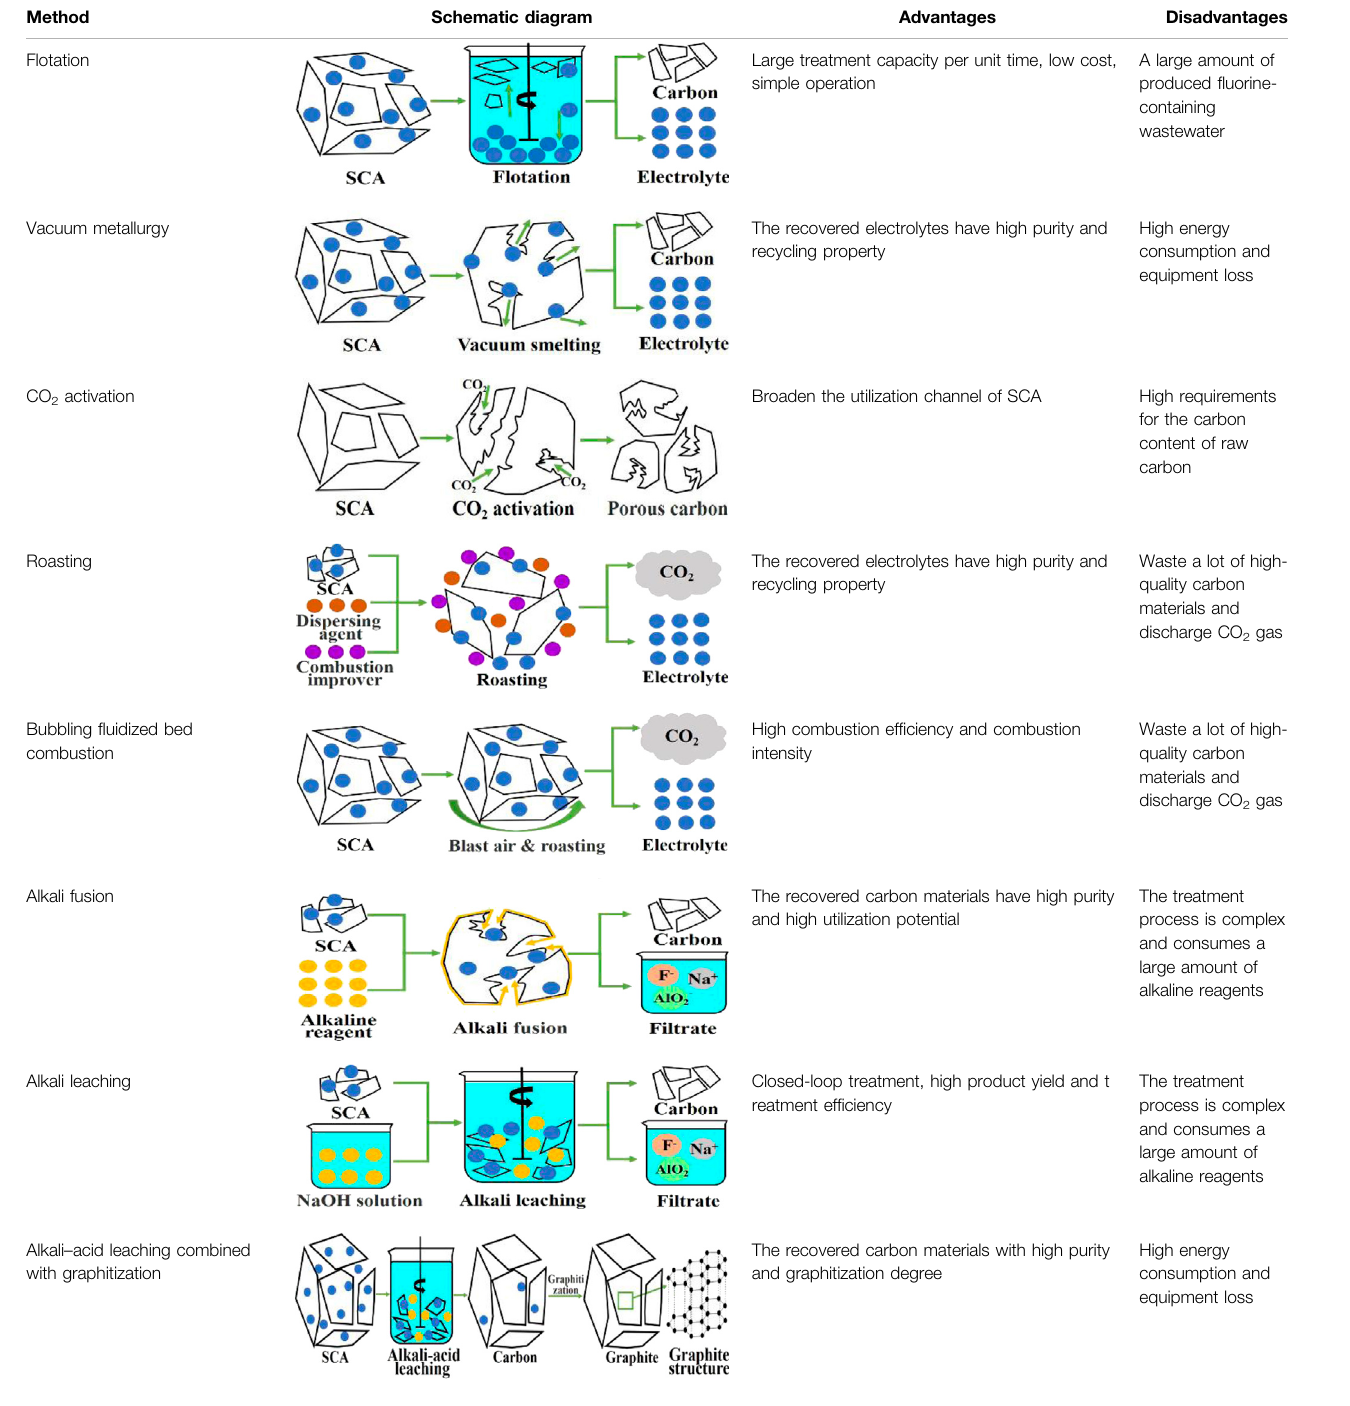
TABLE 4 | Principle, advantages, and disadvantages of existing methods for the safe disposal and comprehensive utilization of